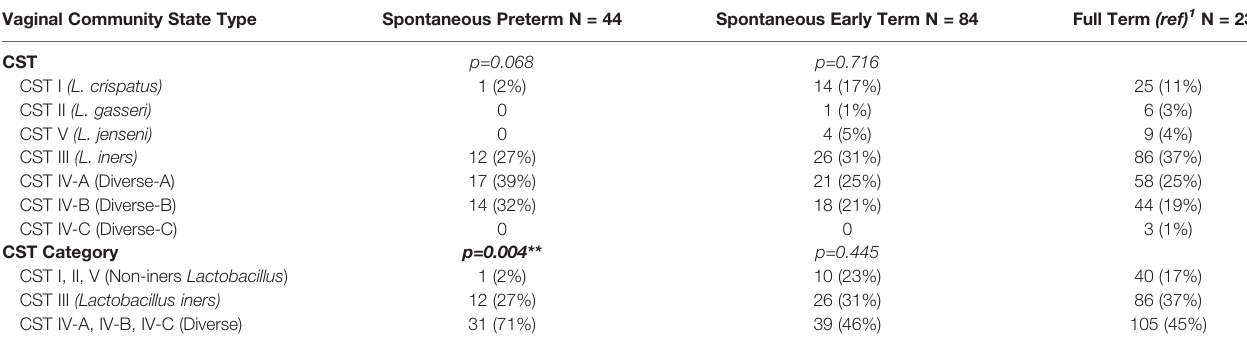
1 p-value indicates the result of the Chi-square test of signi fi cance with full term births as referent category; bold indicates statistical signi fi cance for a = 0.05.